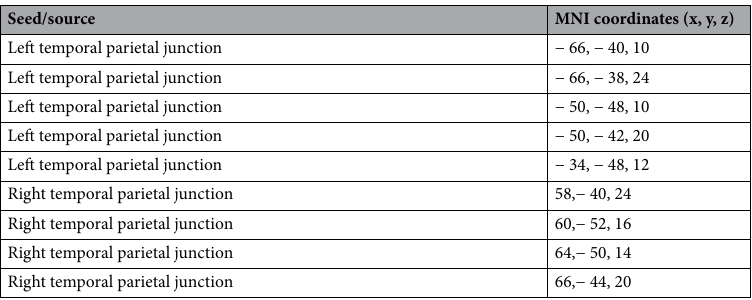
Table 4. The list of the sources included in the resting-state functional connectivity analysis. The Montreal Neurological Institute (MNI) coordinates of the central positions of the seeds were taken from the work by Davis et al. 27 , who found nine regions belonging to either the left or right temporal parietal junction, activated by the fMRI visual temporal order judgment